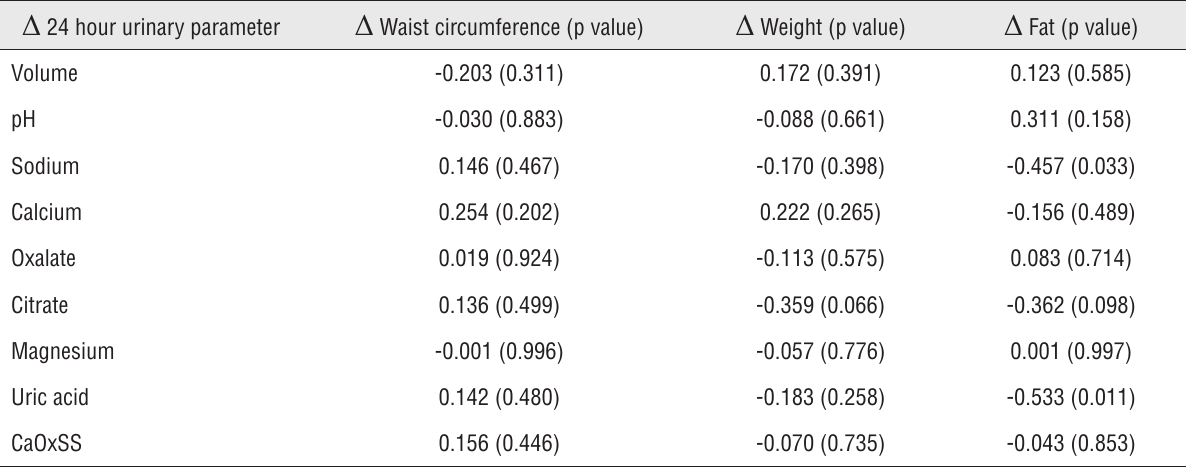
Supplementary Table 5 - Correlation between 24-hour urinary parameters change and weight change, abdominal circumference change and fat mass change in 27 females.